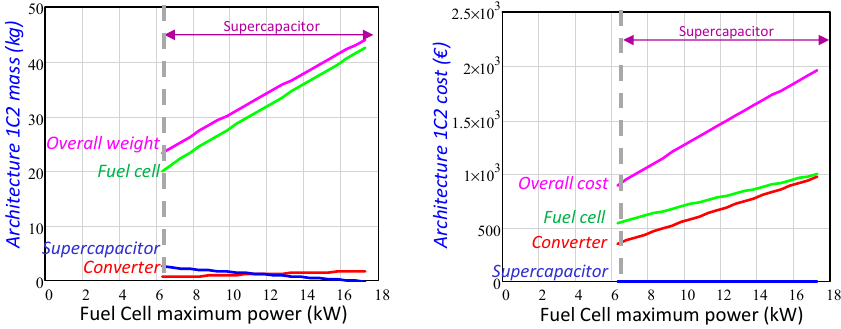
Figure 18. Architecture 1C1 mass and cost.